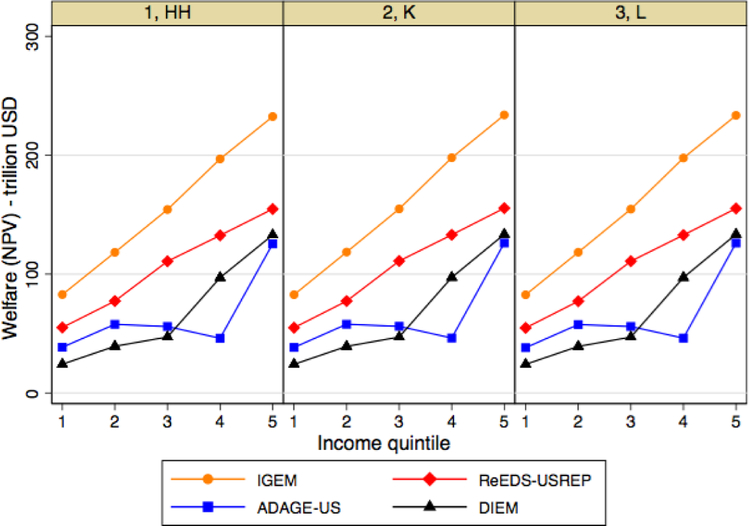
Distribution of welfare across income groups by model and
revenue recycling scheme for $25 at 5% CO2 price path. Note
that the distribution of welfare (levels) across models varies quite a
bit. IGEM includes more leisure, explaining the larger differences
between welfare and consumption impacts in that model. ADAGE has
different patterns because it defines quintiles differently.